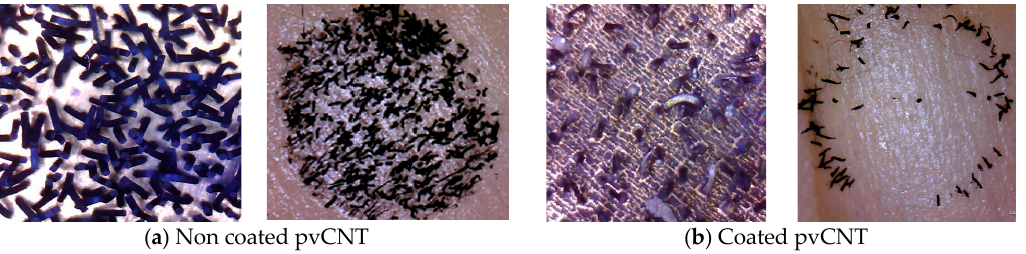
Figure 8. Microscopy images of pvCNT prior to and after the peel-off experiments. ( a ) A non-coated pvCNT electrode prior to the test and the residue left on the tape after the test. ( b ) PPy-coated pvCNT electrode prior to the test and the residue left on the tape after the test.